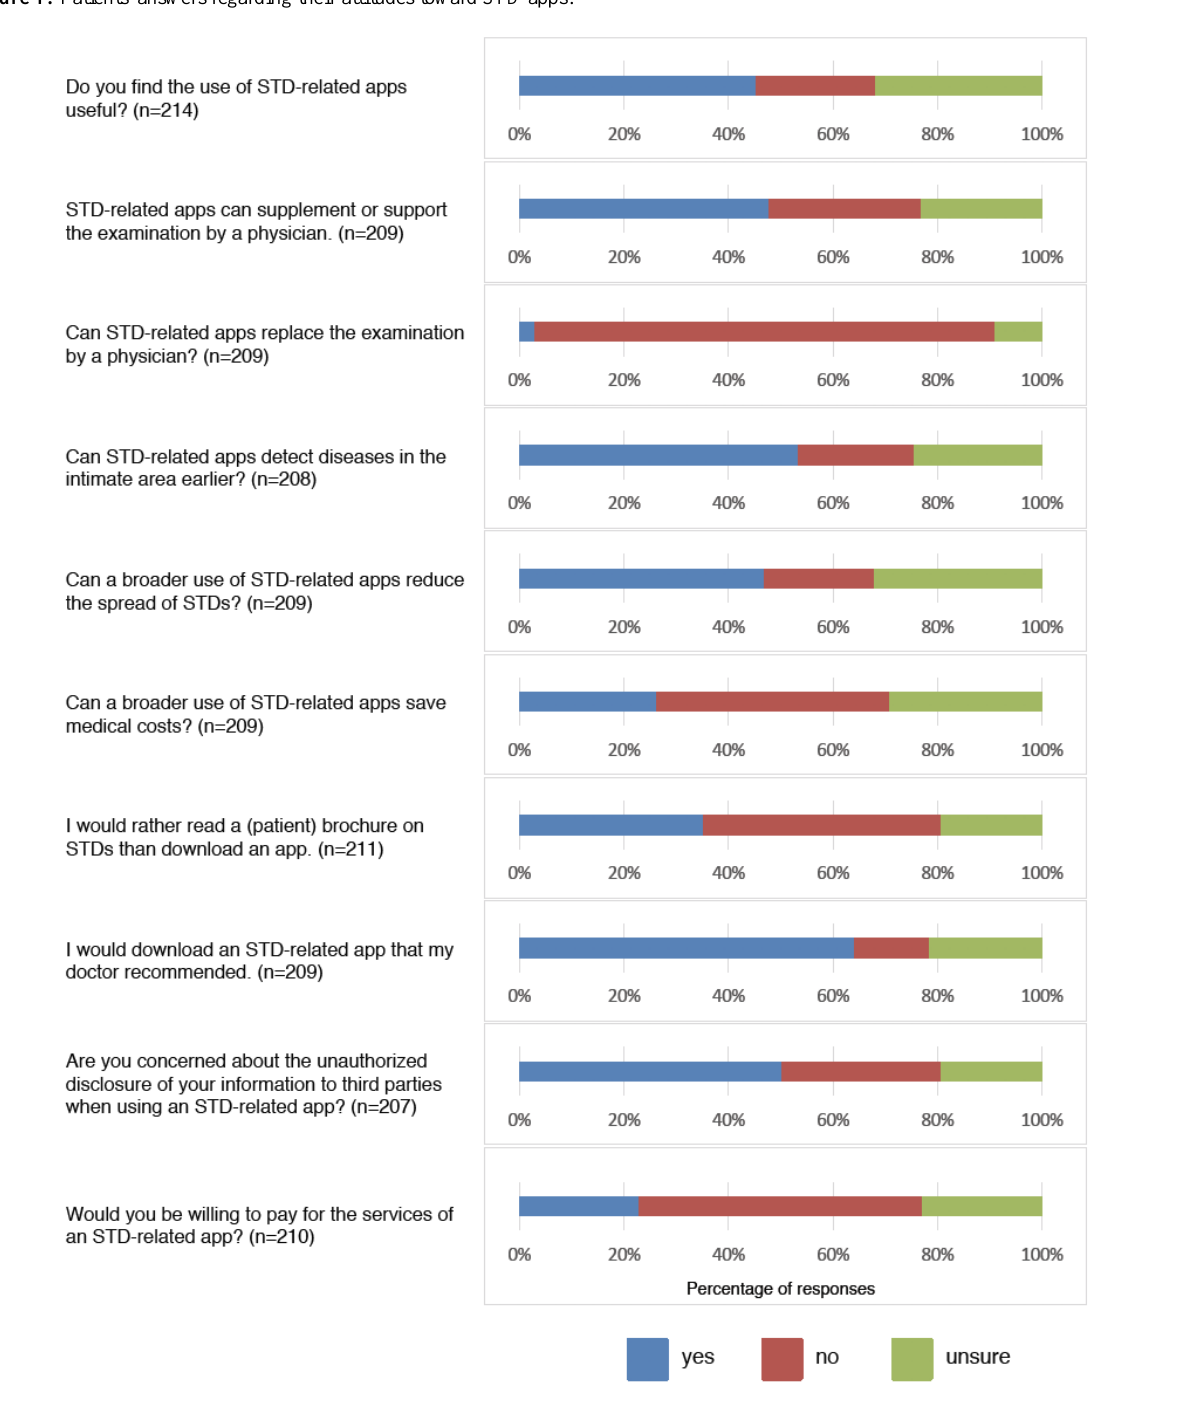
Figure 1. Patients' answers regarding their attitudes toward STD